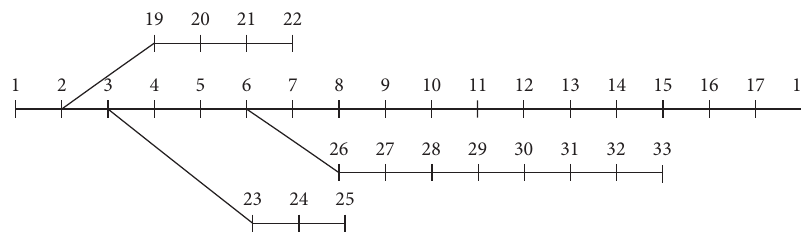
Figure 4: Diagram of IEEE 33-node standard distribution system.